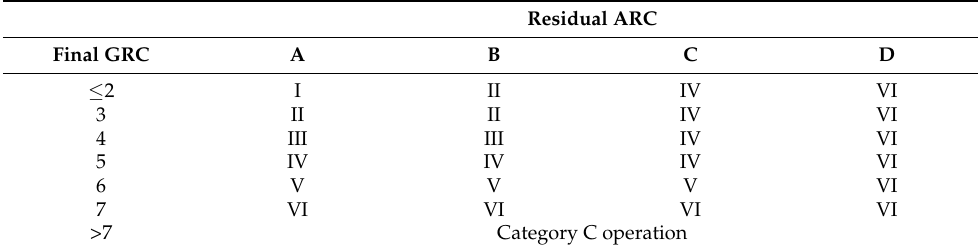
Table 9. SAIL determination